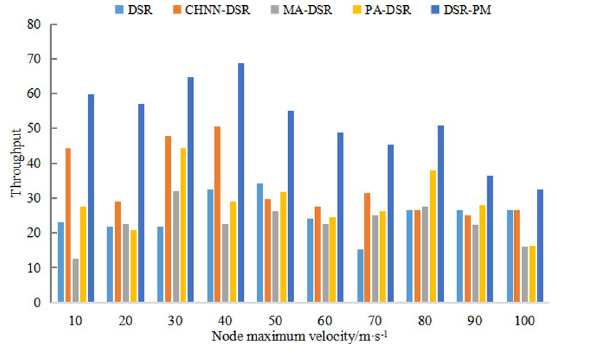
Fig 6. Throughput comparison diagram.